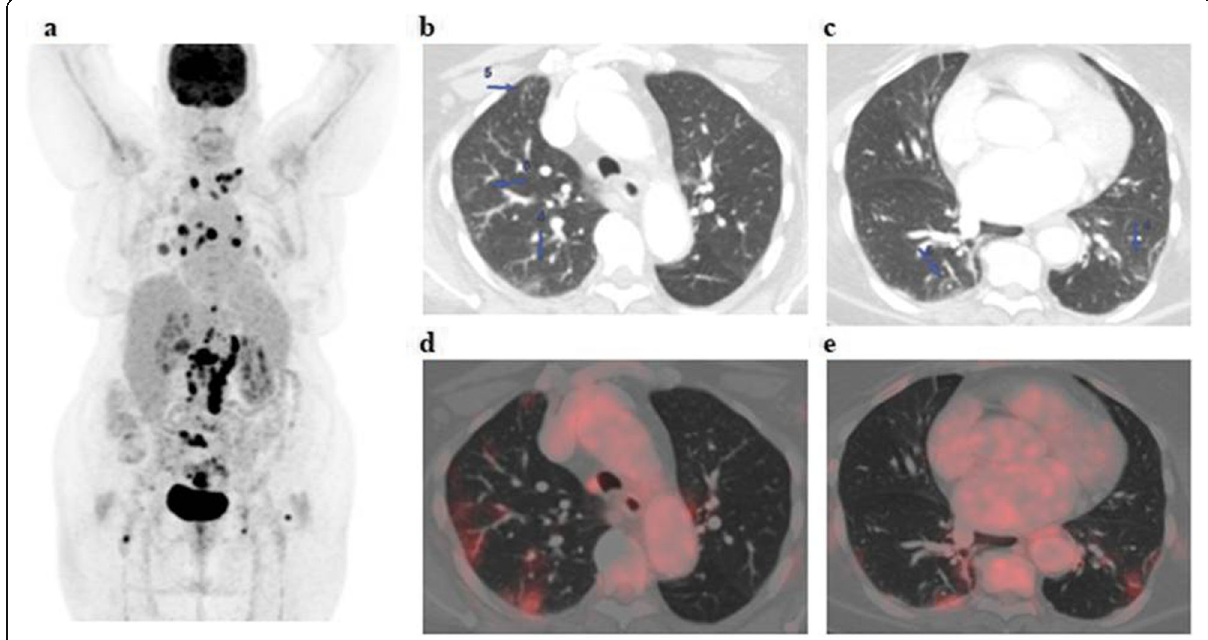
Fig. 3 A 74-year-old female patient, presented with low back pain and previously done lumbosacral spine MRI which revealed malignant looking osseous lesions and referred for further assessment by PET/CT examination. The whole-body MIP image ( a ) shows multiple FDG avid nodal and osseous lesions with bilateral pulmonary areas of mild active FDG uptake. Axial lung window CT images ( b , c ) revealed small-sized bilateral subpleural ground-glass opacities that show mild FDG avidity on corresponding fused PET/CT images ( d , e ) achieving up to 4.3